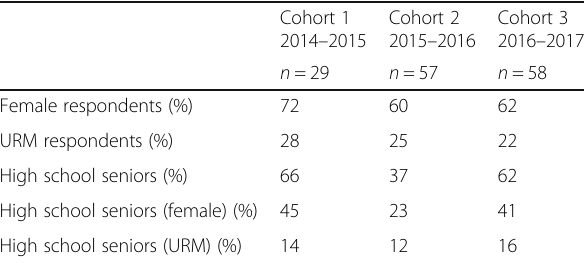
Table 2 End-of-year student survey